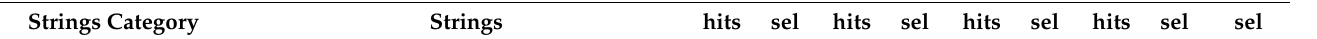
Table 2. Scoping results of selected articles based on the four database sources (From 2000–2019, English language-based literature). Strings Category